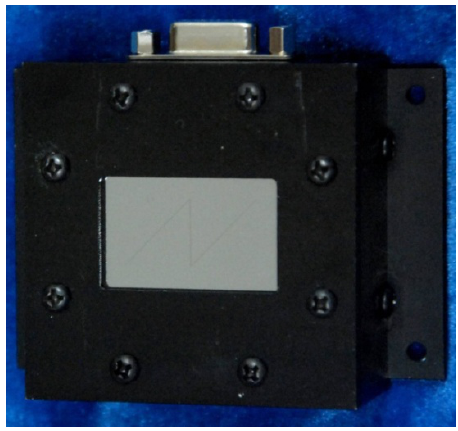
Figure 10. Prototype of digital sun sensor with N -shaped